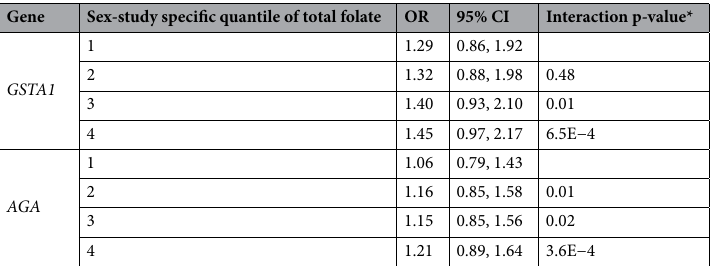
Gene Sex-study specific quantile of total folate OR 95%